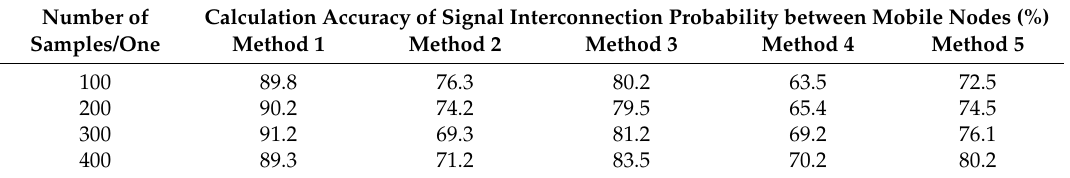
Accuracy of signal interconnection probability between mobile nodes based on different methods. Number of Calculation Accuracy of Signal Interconnection Probability between Mobile Nodes (%)